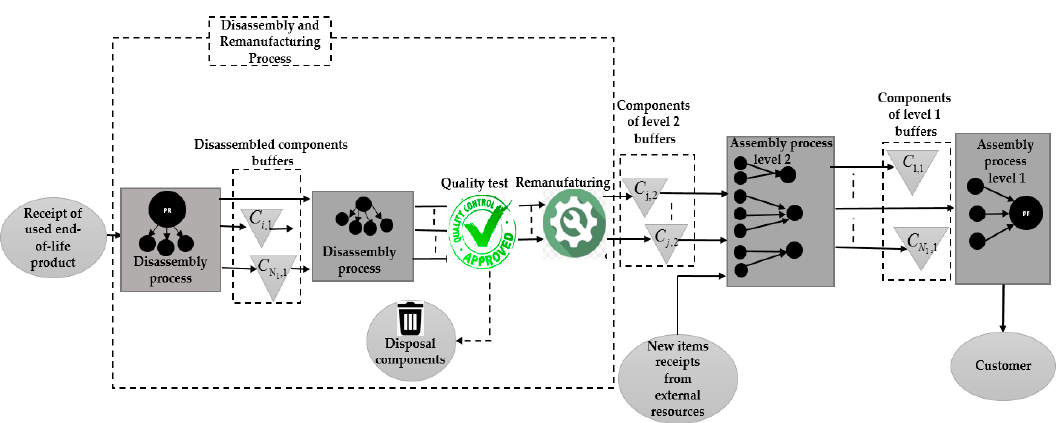
Figure 1. System Description.